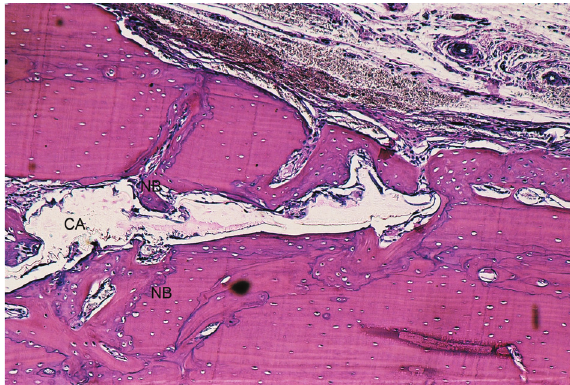
Figure 4- Group II – 30 days: Underneath, bone graft is linked to the recipient site only in the graft margin. Areas